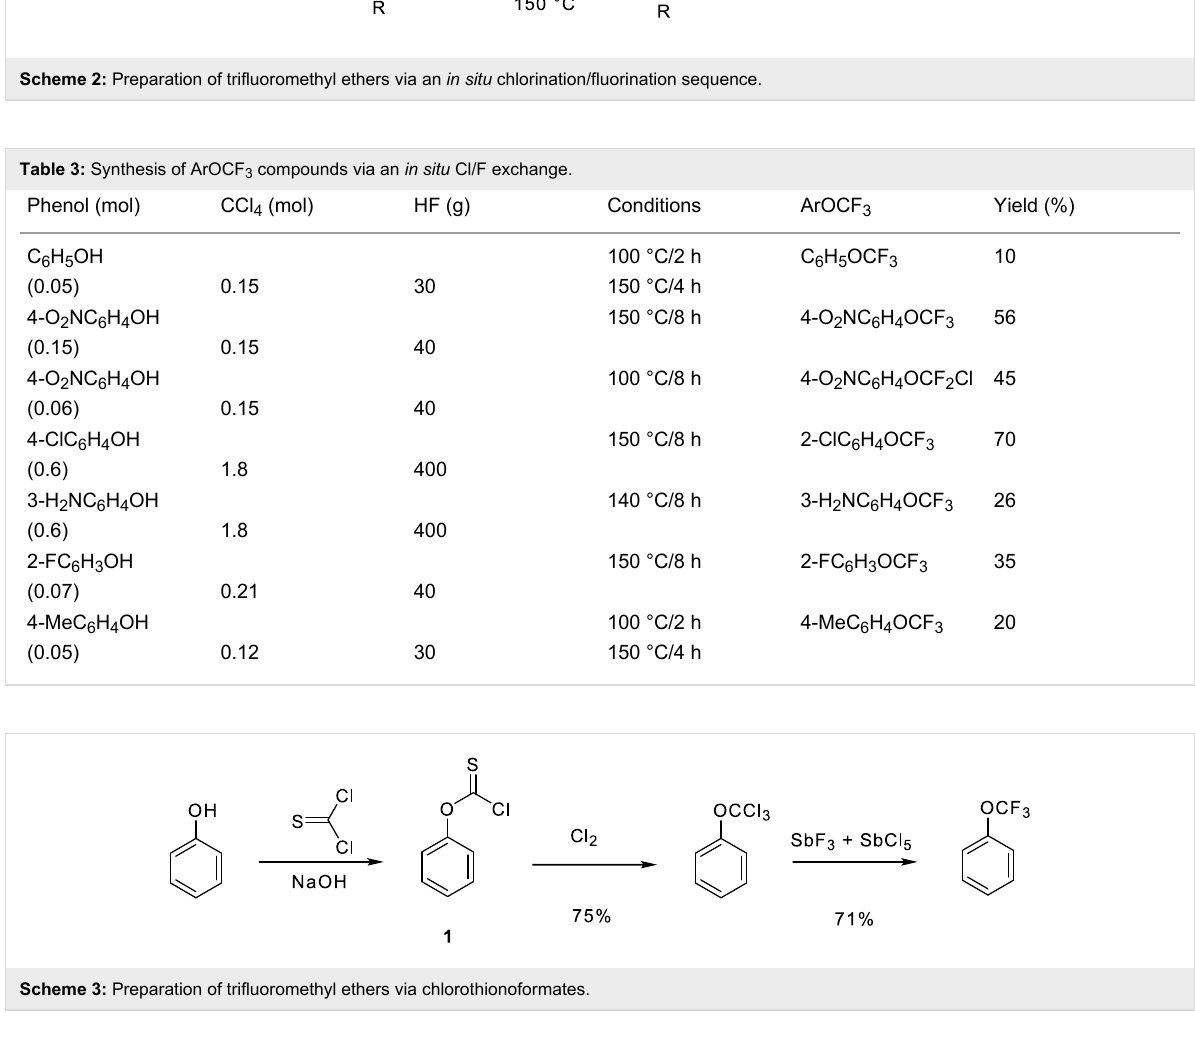
Scheme 3: Preparation of trifluoromethyl ethers via